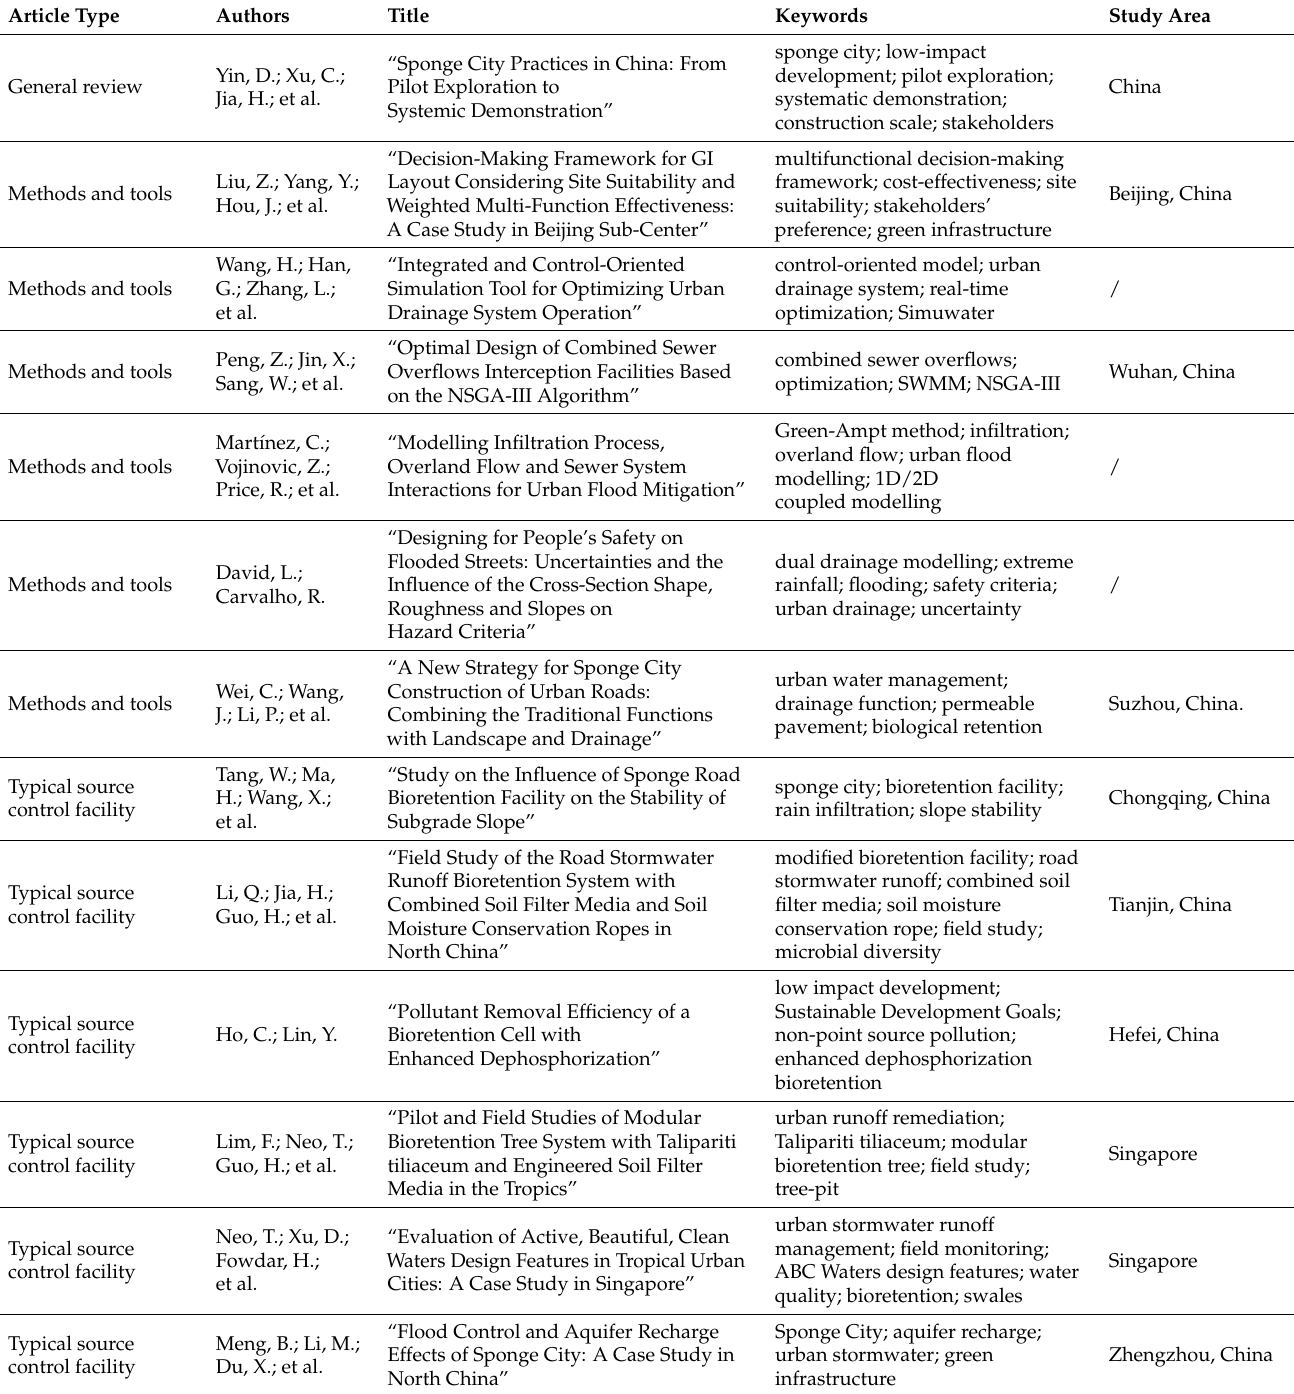
Table 1. Summary of the papers published in the Special Issue “Urban Runoff Control and Sponge City Construction” for the journal Water (https://www.mdpi.com/journal/water/special_issues/ UrbanRunoff_Control accessed on 13 June